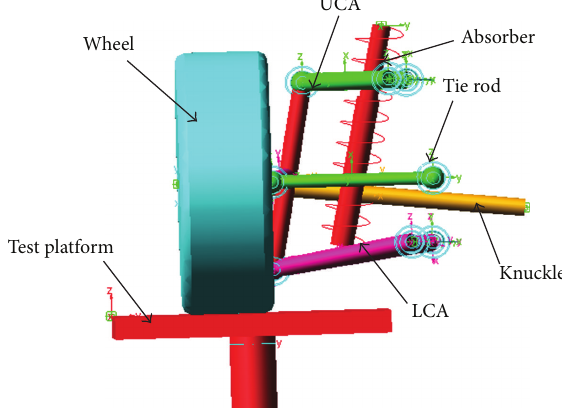
Figure 2: Double wishbone suspension model.